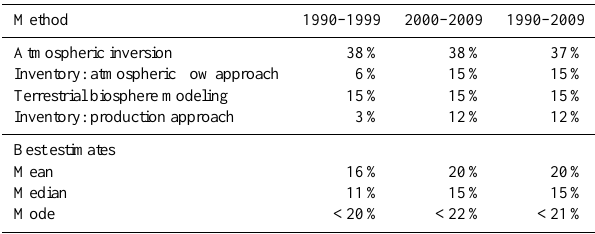
Table 5. Estimates of mean annual net land–atmosphere exchange of CO 2 -C for North America by decade and for 1990–2009 as a pro- portion of the global mean annual net land–atmosphere exchange for those same